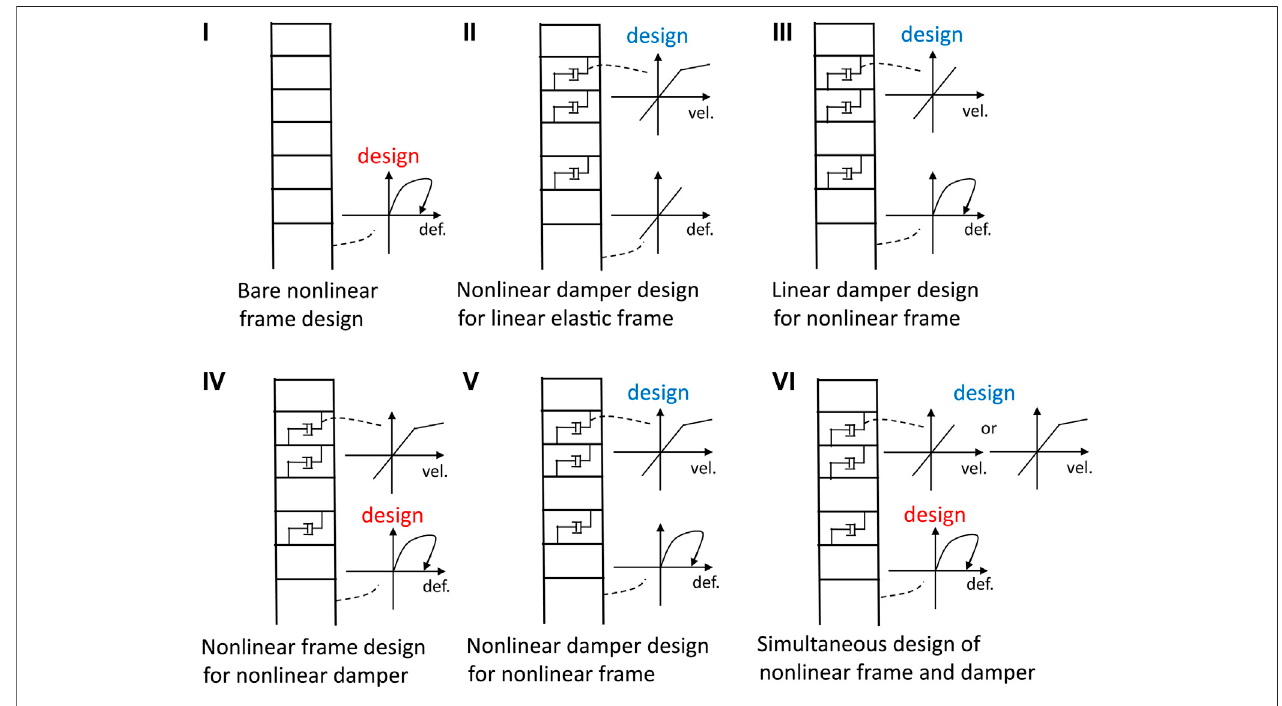
FIGURE 1 | Various optimal design problems discussed in this